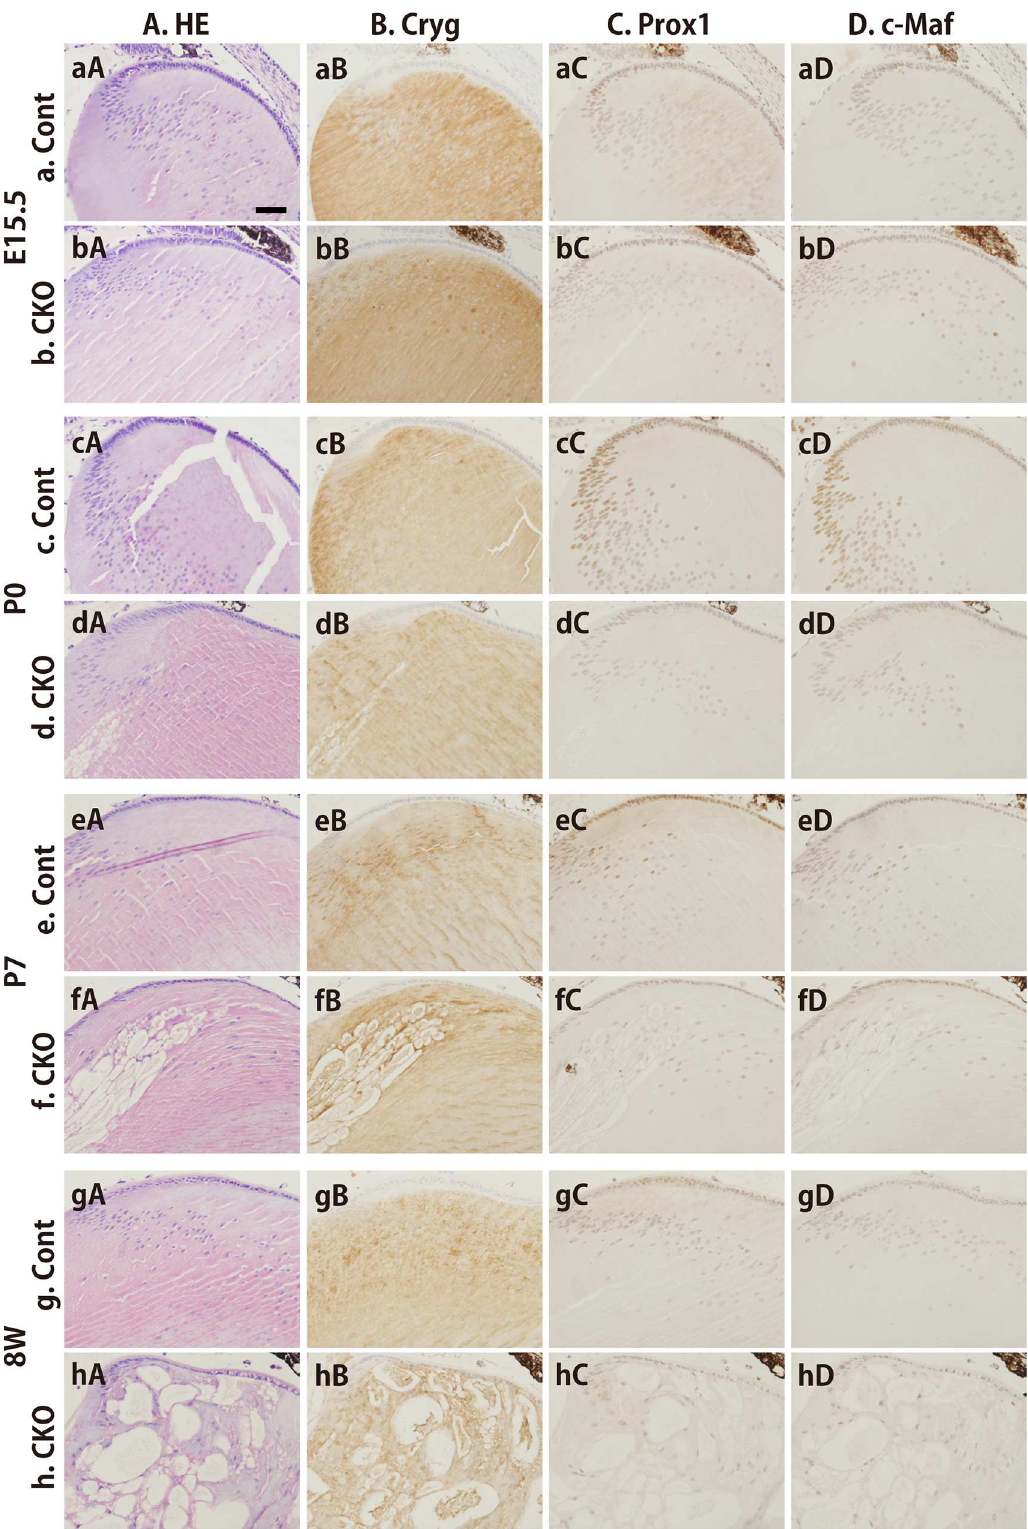
Fig 5. Immunohistochemical detection of lens markerproteinsin lensesfrom a Rest –deficient mouse in vivo . HE staining(A) and immunohistochemicalstainingwith antibodies againstCryg(B), Prox1 (C),and c-Maf(D) at